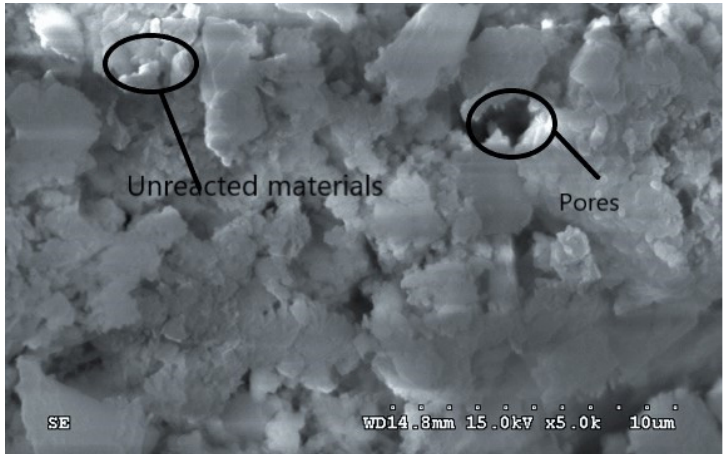
Figure 17. GA7 paste SEM in 5000 k image.